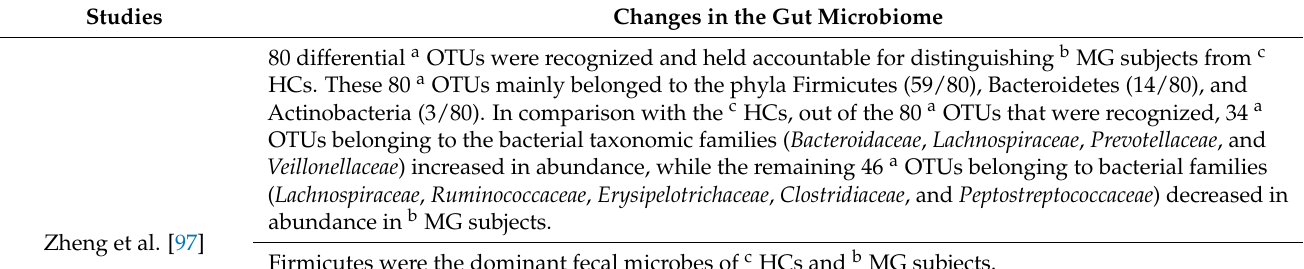
Table 1. Gut microbiome findings in myasthenia gravis (MG)